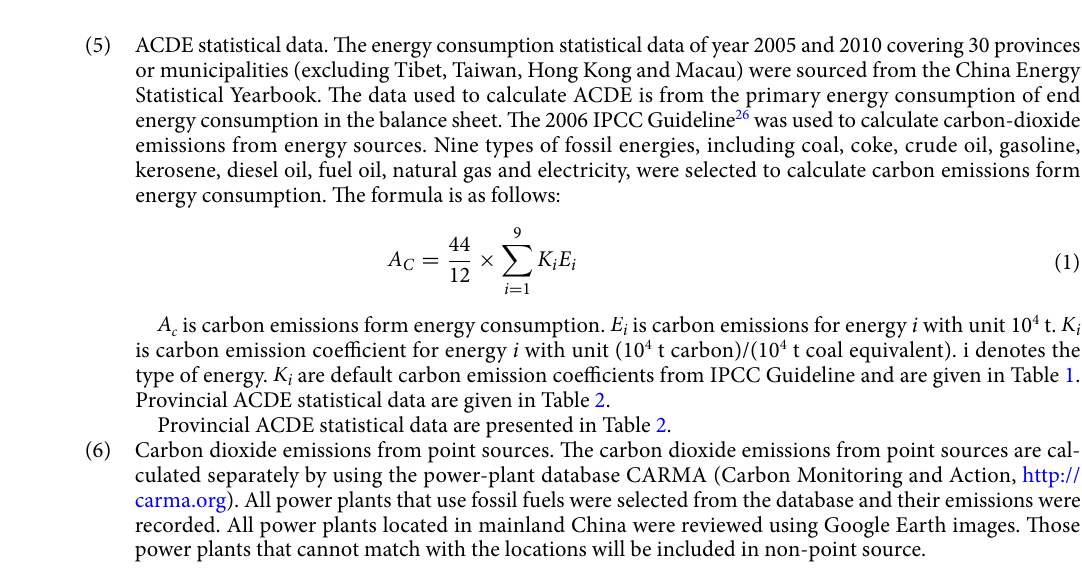
Figure 2. The datasets in 2010, ( a ) DMSP, ( b ) PD, ( c ) GDP, ( d ) EVI. The figs were generated using the ArcGIS Desktop (ESRI, Inc, Version 10.2, https:// deskt op. arcgis. com/ zh-